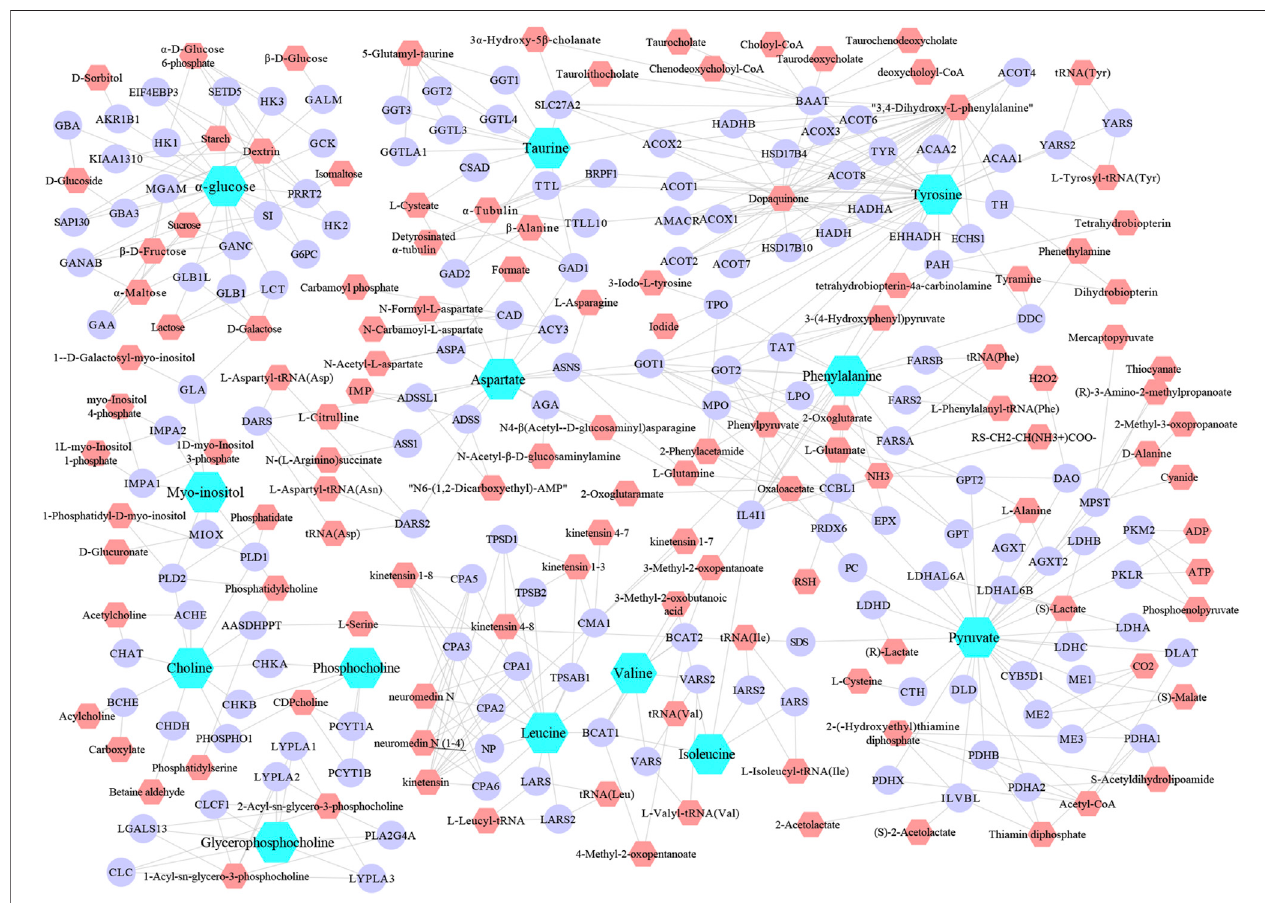
FIGURE 6 | The metabolic networks involved in enzymes, genes and related-compound were established based on the differential metabolites. Light-blue, blue and pink nodes represent differential metabolites, enzymes/genes and related-compound.